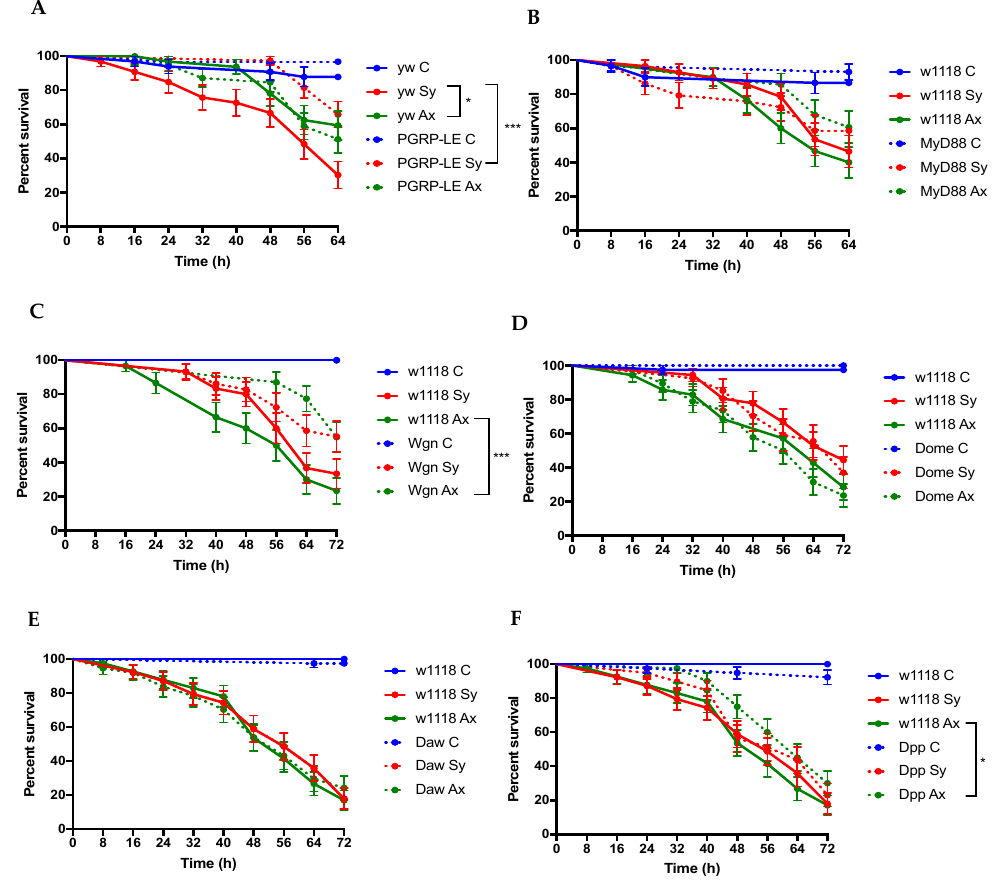
Figure 2. Survival response of Drosophila melanogaster immune mutant larvae infected with Steinernema carpocapsae symbiotic or axenic nematodes. Survival of late second to early third instar D. melanogaster larvae mutant for ( A ) PGRP-LE ; ( B ) MyD88 ; ( C ) Wengen ( Wgn ); ( D ) Domeless ( Dome ); ( E ) Dawdle ( Daw ); or ( F ) Decapentaplegic ( Dpp ) genes, infected with symbiotic (Sy) or axenic (Ax) S. carpocapsae nematodes. Wgn -RNAi and UAS- Dome DN were crossed with ubiquitous Actin-Gal4 driver. Treatment with water served as control ( C ). Larval survival was monitored every 8 h for up to 64 h post-infection. Values represent percent survival of infected larvae and data were analyzed using the Log-Rank test using GraphPad Prism 7 software. The means from three independent experiments are shown and bars represent standard errors. * p < 0.05, ** p < 0.01, *** p < 0.001. Non-significant differences ( p > 0.05) are not